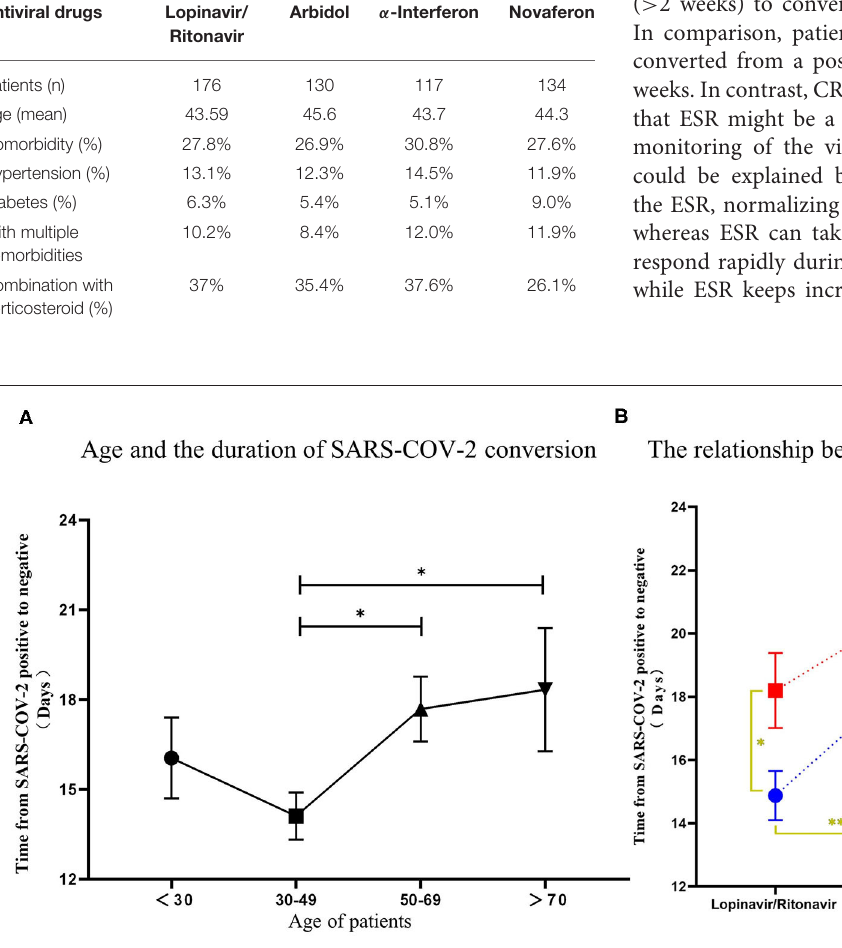
FIGURE 4 | The relationship between age and the conversion time from real-time PCR (rtPCR) positive to negative during antiviral treatment. (A) Patients were grouped by age < 30 years, 30–50 years, 50–70 years, and over 70 years, and the conversion time from rtPCR positive to negative was compared. (B) Patients were divided by different antiviral drugs used, and the time was compared for rtPCR positive to negative results in patients under and over the age of 50. Data are represented the mean ± SEM. The significance was determined as * p < 0.05, ** p < 0.01, and *** p < 0.001.